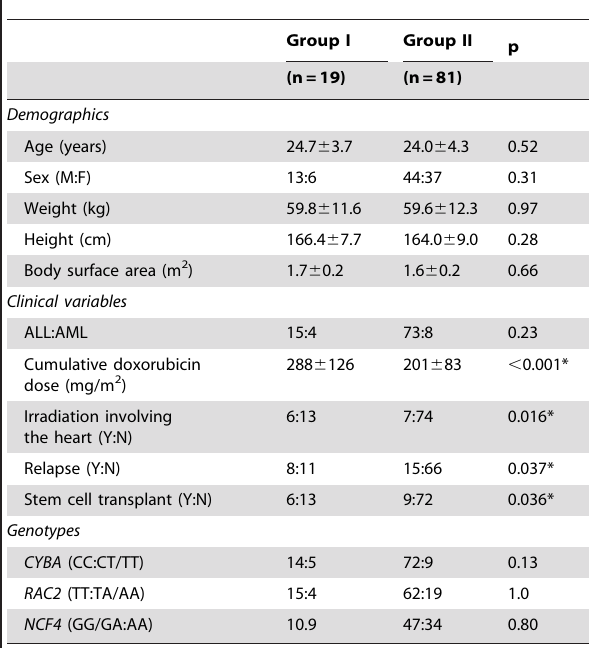
Table 2. Comparisons of demographic factors, clinical variables, and genotypic frequencies between survivors with (group I) and without (group II) elevated hs-cTnT